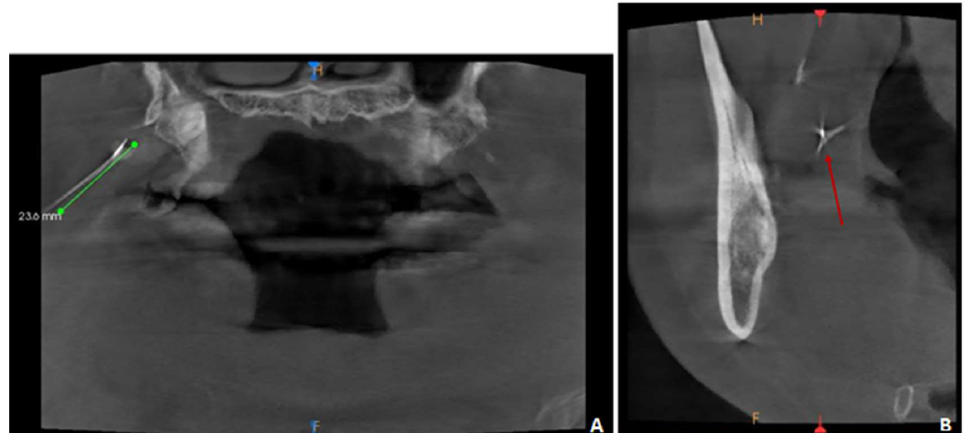
Figure 2. Latero-lateral skull teleradiography showing the fractured needle (red circle).